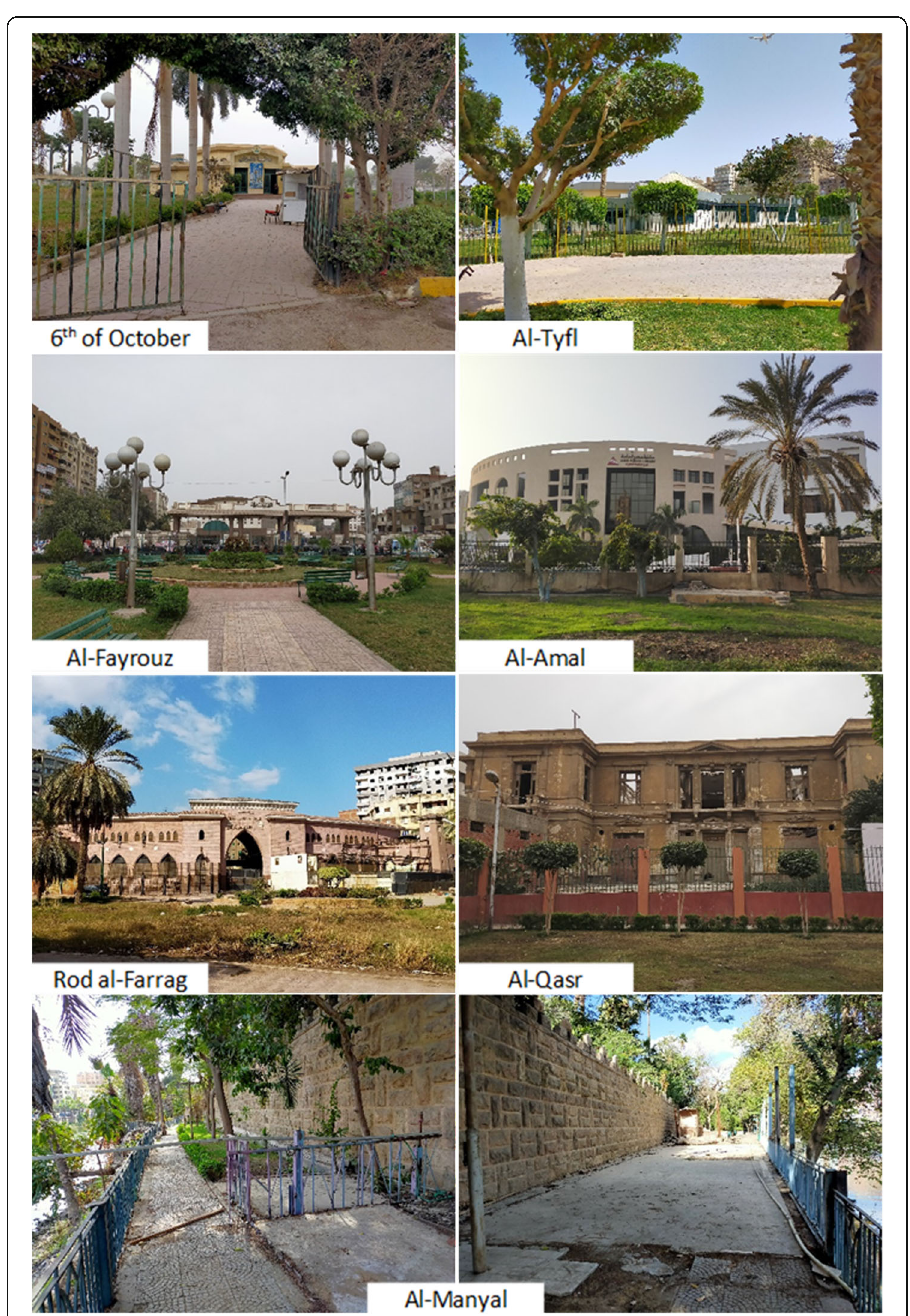
Fig. 15 Separation of uses in Cairo ’ s public